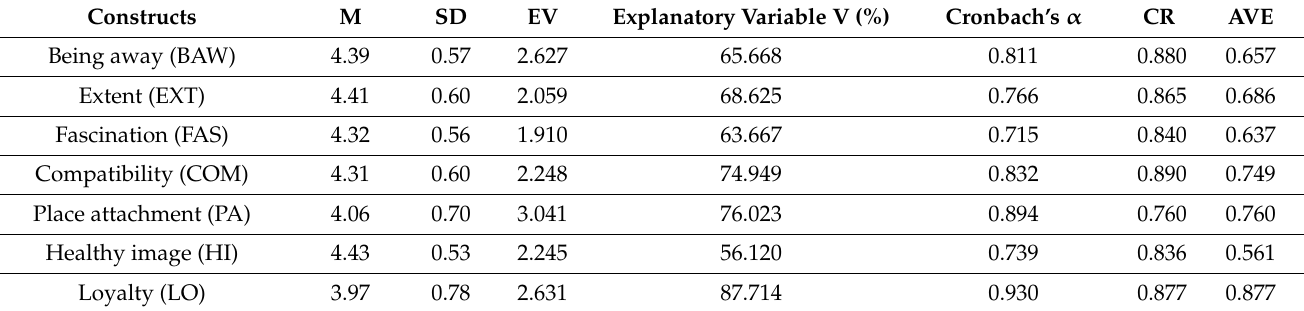
Table 3. Factor analysis and reliability